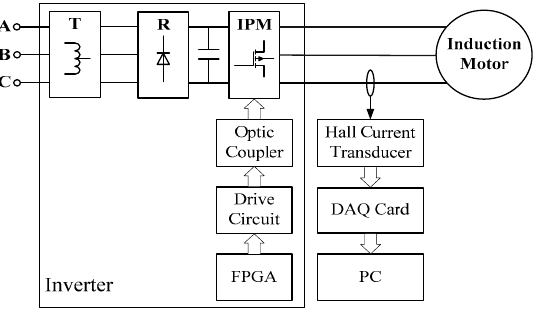
Figure 12. Schematic diagram of a drive system based on FPGA.